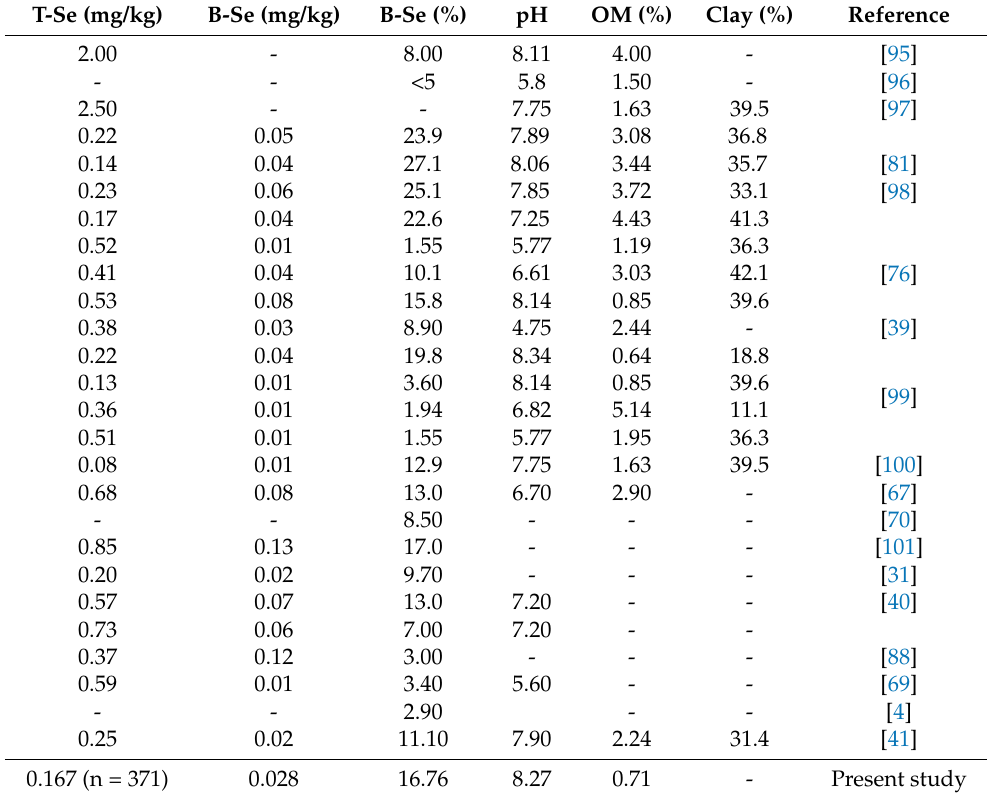
Table 1. Proportion of bioavailable Se in total Soil Se in previous studies.